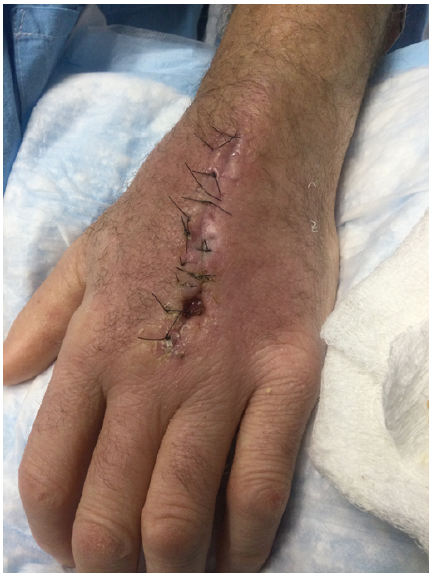
Figure 11. Representative photograph of the patient’s left hand fol- lowing multiple irrigation and debridement procedures and contin- uous drainage and poor wound